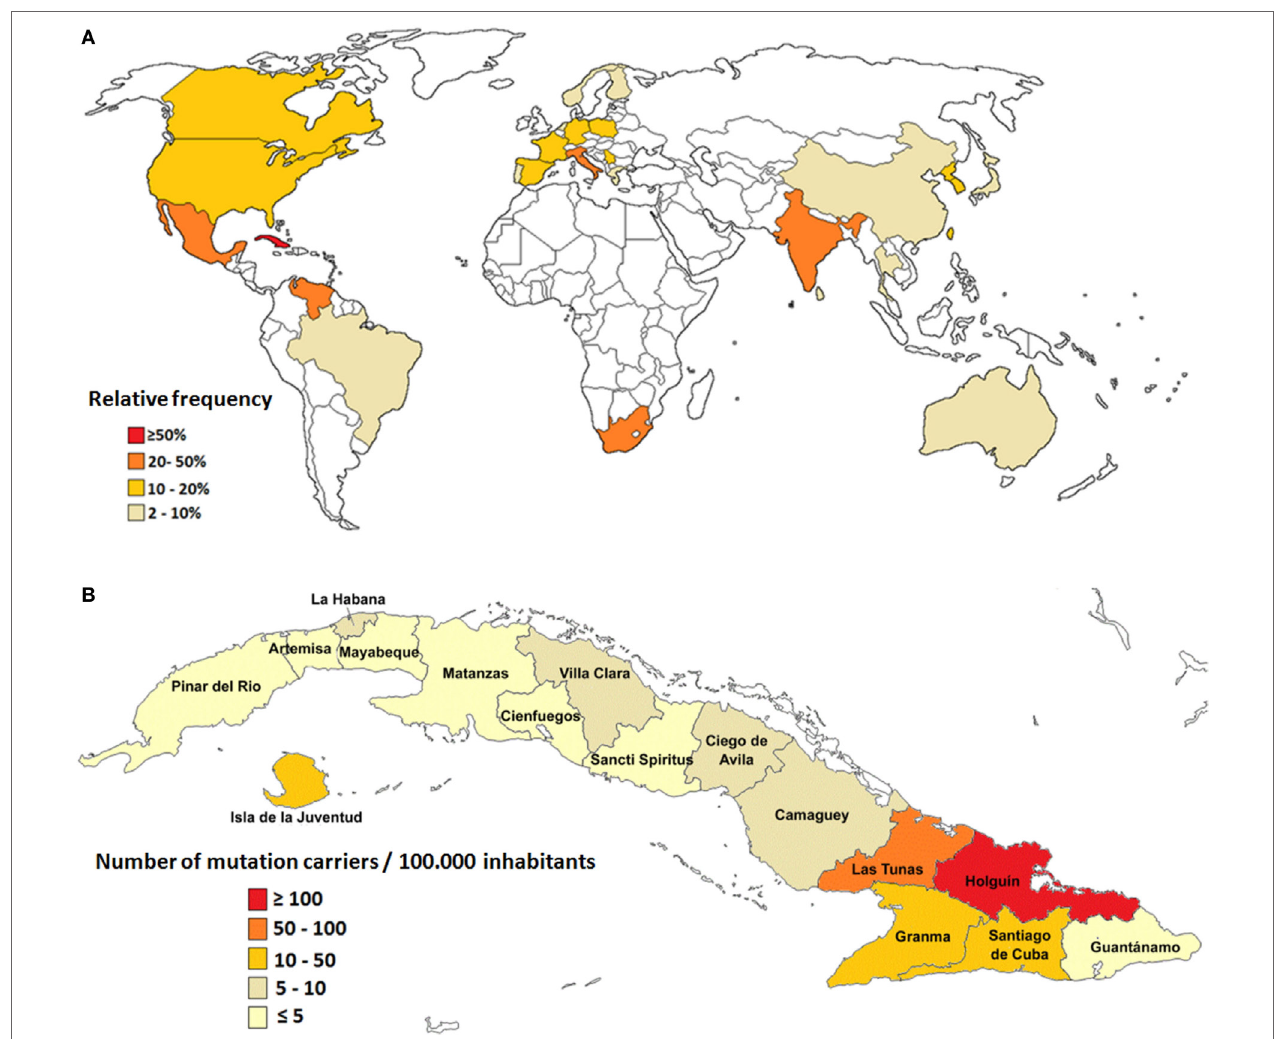
FiGURe 1 | Epidemiological features of spinocerebellar ataxia type 2 (SCA2). (A) Relative frequency of SCA2 around the world. (B) Prevalence rates of SCA2 in